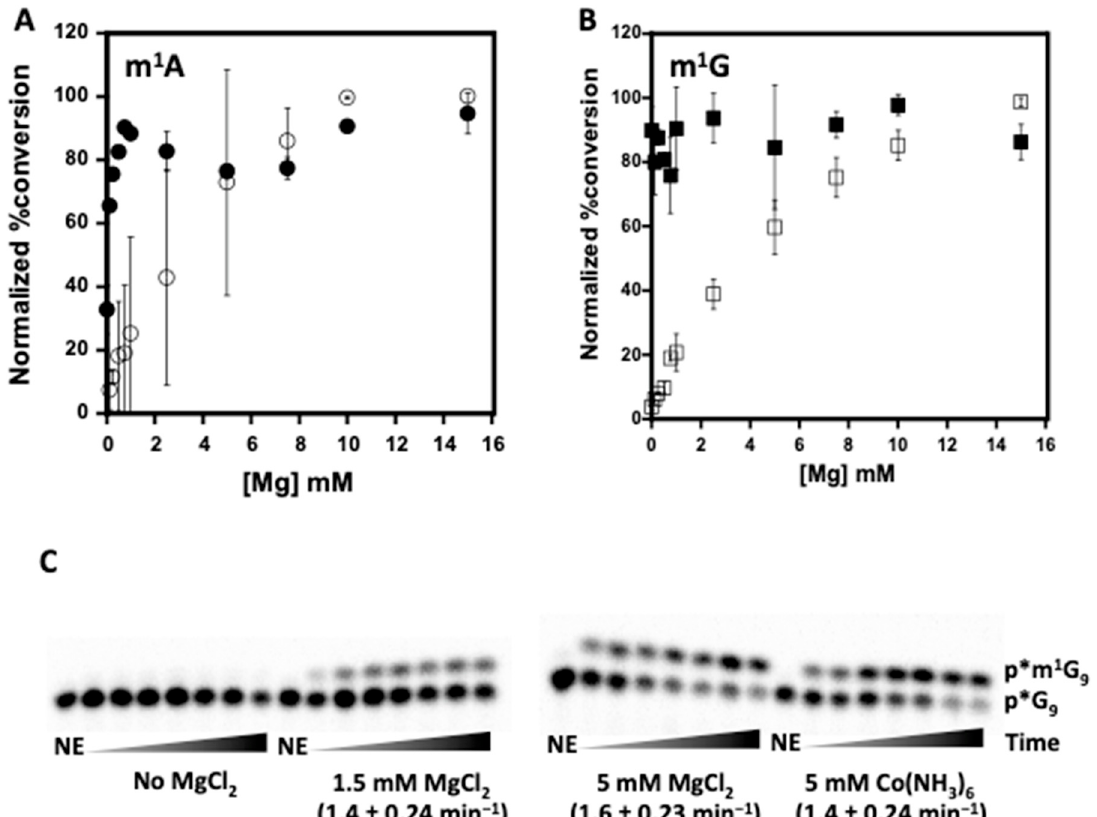
Figure 2. Substrate-dependent effects of Mg 2+ on catalysis by TkTrm10. ( A ) Mg 2+ dependence of m 1 A 9 formation by TkTrm10 purified under metal-free conditions. Product formation after 1 h of reaction was quantified as described in methods for SctRNA Phe (open circles) and TktRNA Thr (filled circles). Each data point represents the average of at least two independent experiments, with error bars indicating standard deviation. ( B ) Mg 2+ dependence of m 1 G 9 formation by TkTrm10 purified under metal-free conditions. Product formation after 1 h of reaction was quantified as described in methods for SctRNA Phe -G9 (open squares) and TktRNA Arg (filled squares). Each data point represents the average of at least two independent experiments, with error bars indicating standard deviation. ( C ) Time courses for m 1 G 9 methylation of SctRNA Phe -G9 catalyzed by TkTrm10 in varied concentrations of added MgCl 2 or Co(NH 3 ) 6 , as indicated. Single turnover k obs were determined by fit to Equation (1) and are reported in parentheses under the time course corresponding to each position.